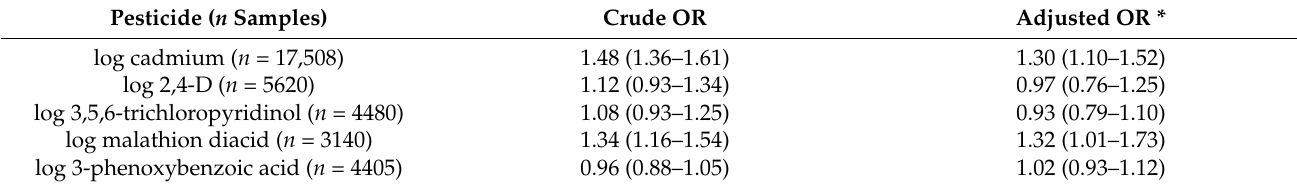
Table 3. Sensitivity analysis of pesticide and low kidney function after excluding participants with hypertension and diabetes in the National Health and Nutrition Examination Survey conducted in the US between 2001–2004 and 2007–2010. Pesticide ( n Samples) Crude OR Adjusted OR * log cadmium ( n =